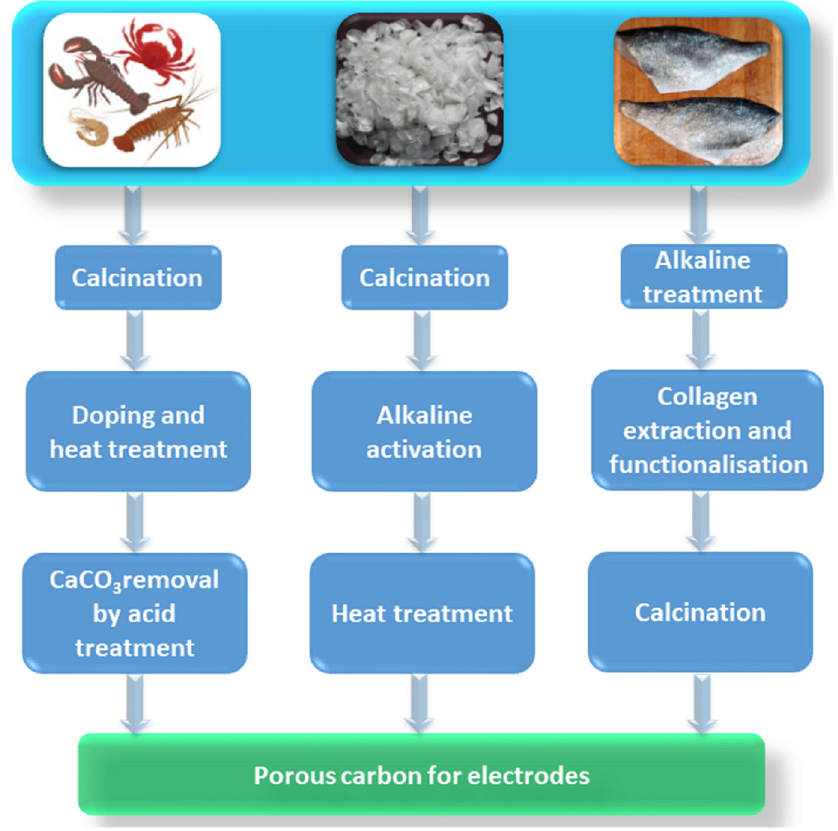
Figure 2. Schematic representation of the possible routes for obtaining porous carbon electrodes for Li-ion batteries from fish waste.